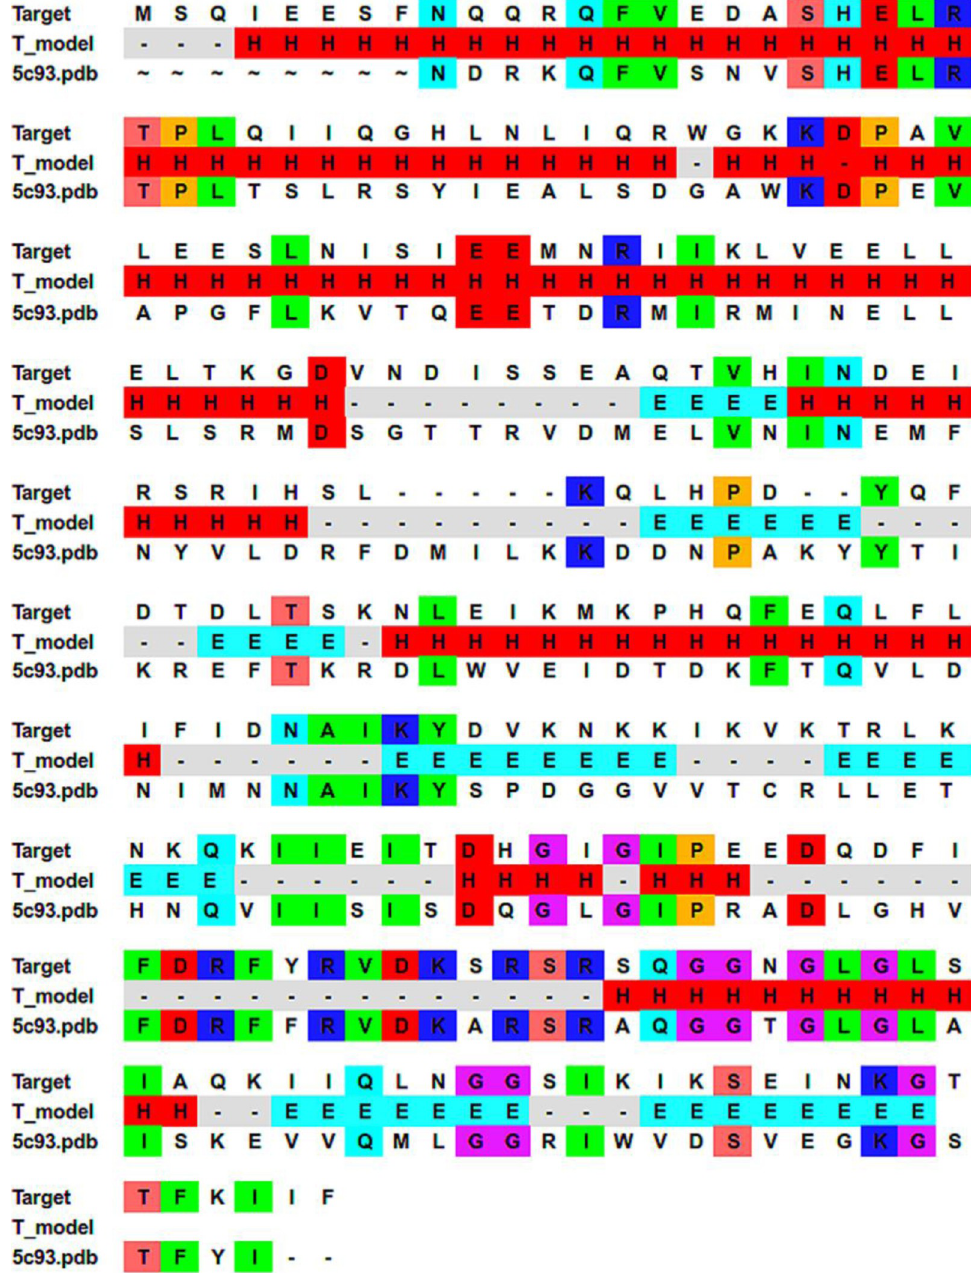
Fig 4. Staphylococcus aureus Q7A2R7 sequence (target) alignment result with template sequence (5c93). The obtained secondary structure is shown, where H represents the helix; E represents the strand; and “-” represents the loop. Identical residues are